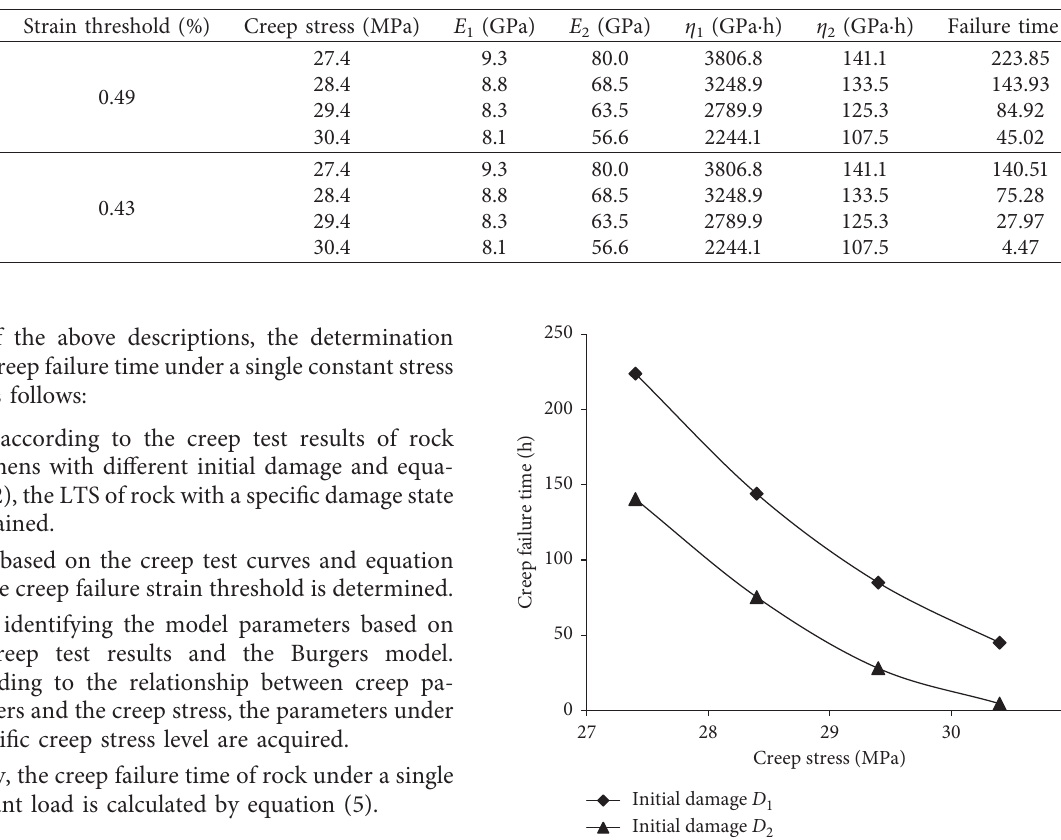
2 and D 3 at different creep levels.